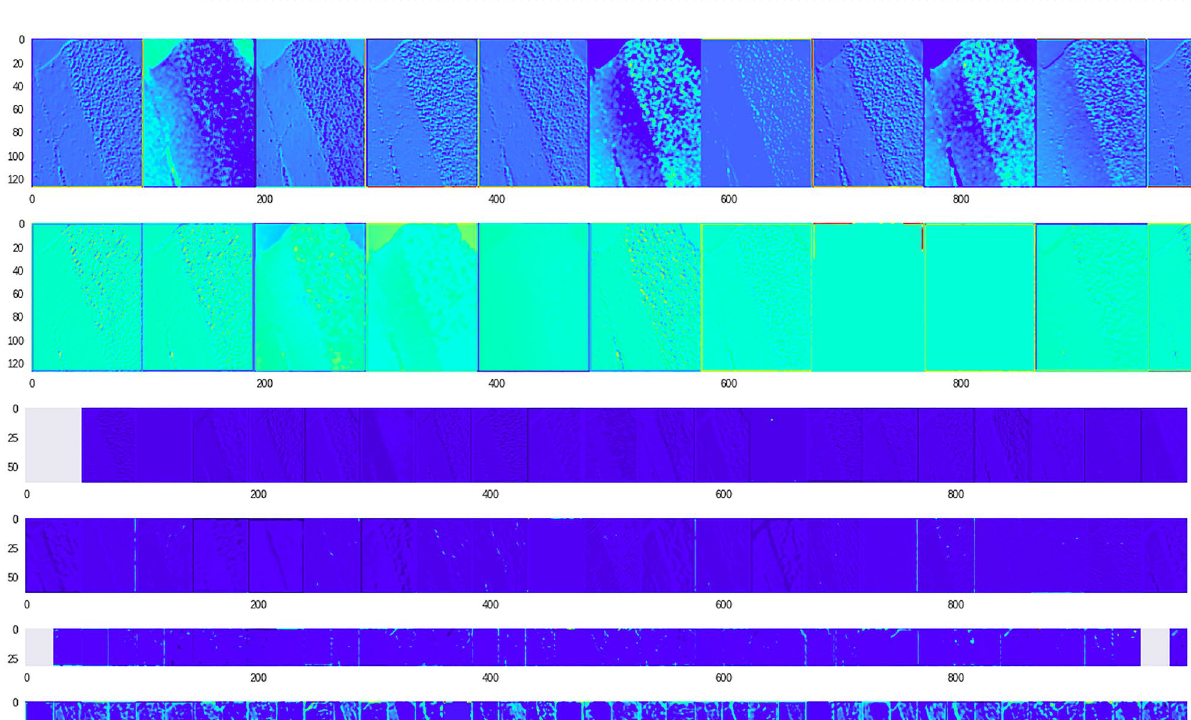
Figure 18. An image of cerebellum correctly classified by majority of MS, VML and IML (Figure generated by Matplotlib python library, version 3.3.4, https:// matpl otlib. org/).